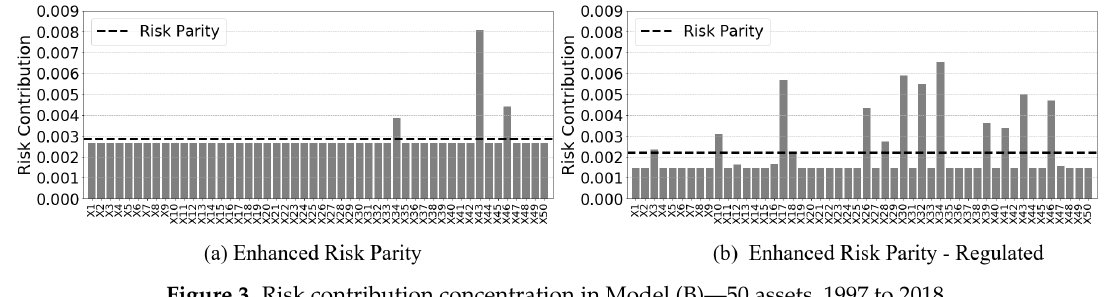
Figure 3. Risk contribution concentration in Model (B)—50 assets, 1997 to 2018.